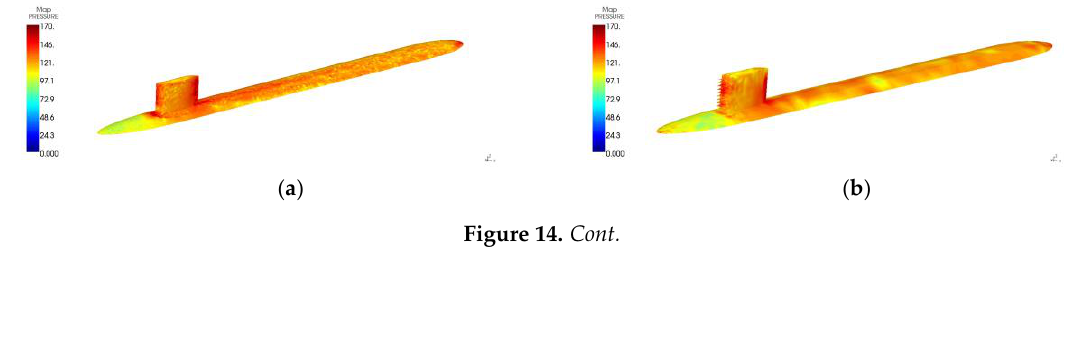
Figure 13. The boundary layer velocity distribution of the three points. ( a ) Point A’; ( b ) Point B’; ( c ) Point C’.